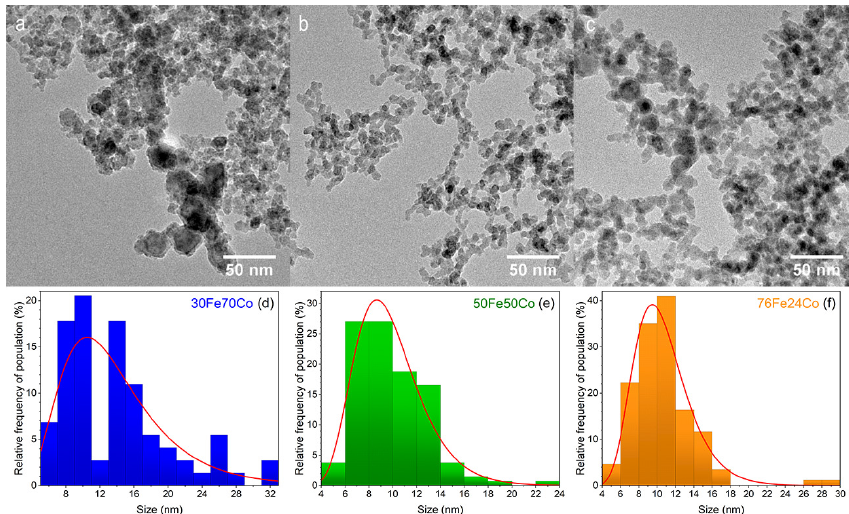
Figure 1. TEM images of xFe(100-x) Co samples with x = 30, 50, 76 in frames ( a – c ), respectively. The corresponding NPs size distributions are given in frames ( d – f ).